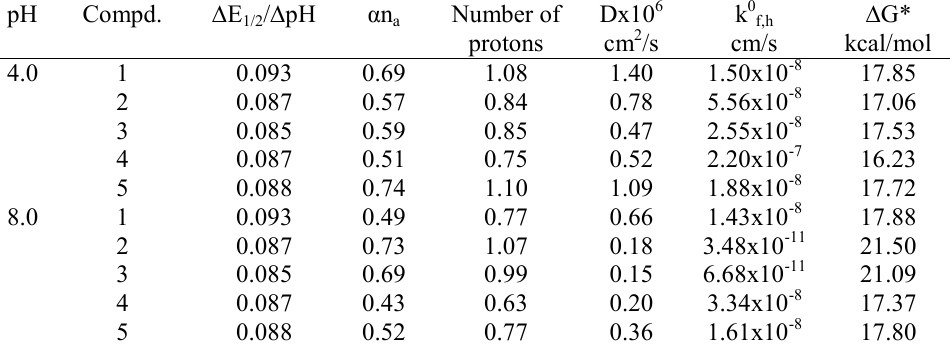
Table 2. Polarographic characteristics and kinetic parameters of compounds 1-5 at pH 4.0 and